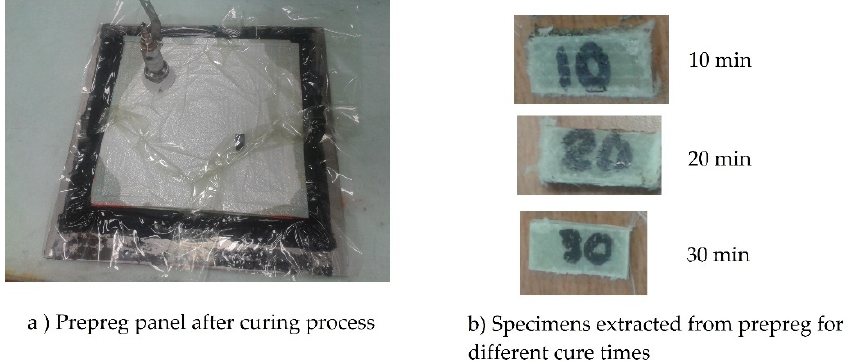
Figure 1. Test specimen manufacturing process: ( a ) Prepreg panel after curing process in vacuum pressure oven, ( b ) example of specimens drawn from prepreg for different cure times.